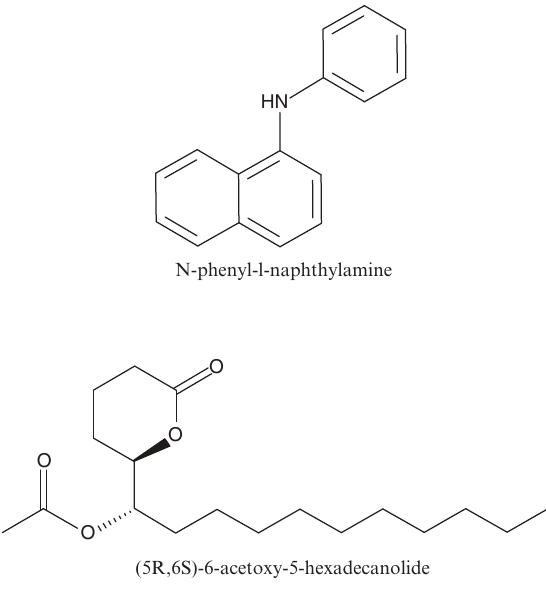
Figure 1. Structures of a fluorescence reporter and a mosquito oviposition pheromone. N-phenyl-1-naphthylamine (NPN) is widely used in binding assays with insect OBPs. (5 R ,6 S )-6-acetoxy-5- hexadecanolide (MOP) is an attractant first isolated from eggs of